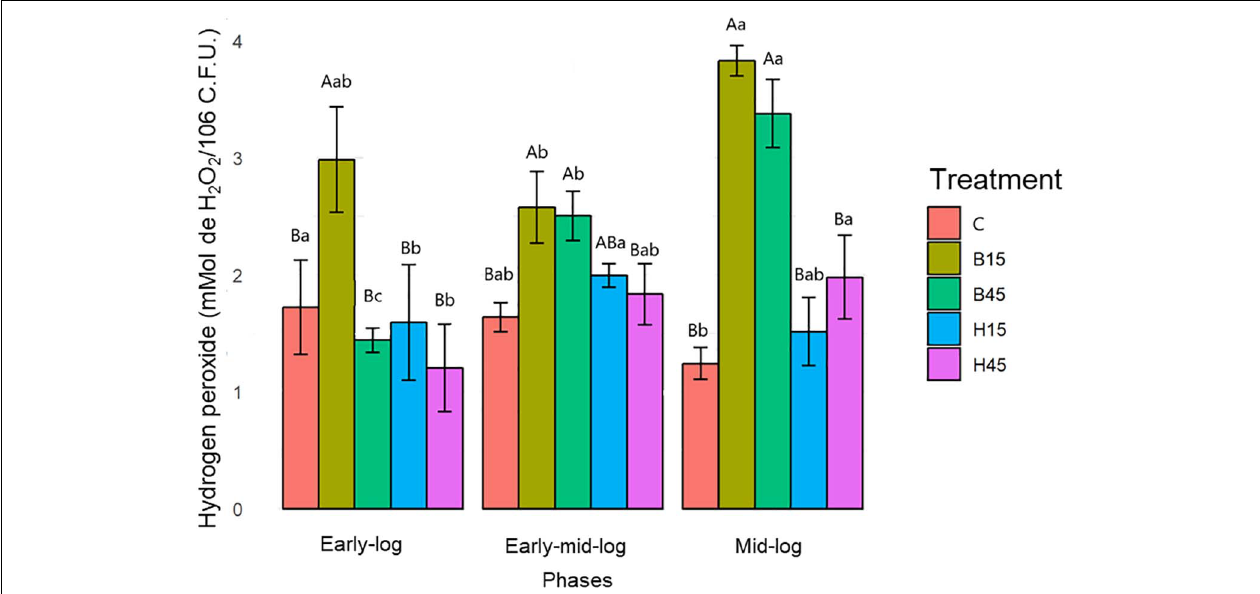
FIGURE 4 | Quantification of H 2 O 2 from Pseudomonas sp. CMA 6.9 in control treatments (C) and with the herbicides Boral R (cid:13) (B15 and B45) and Heat R (cid:13) (H15 and H45) in the three growth phases indicated. Data were obtained in triplicate for each treatment and statistically analyzed using a randomized complete block design using the Duncan test ( p < 0.05). Error bars represent standard errors of the means. Different uppercase letters represent statistically significant differences between treatments at the same time; lower-case letters represent statistically significant differences between treatments at different times.